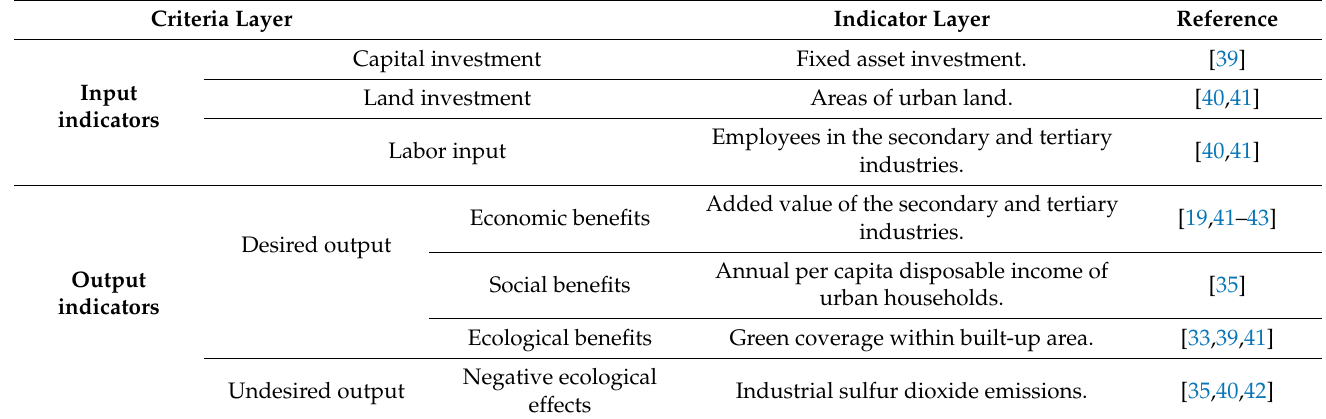
Table 2. Quantitative evaluation index system for urban land use